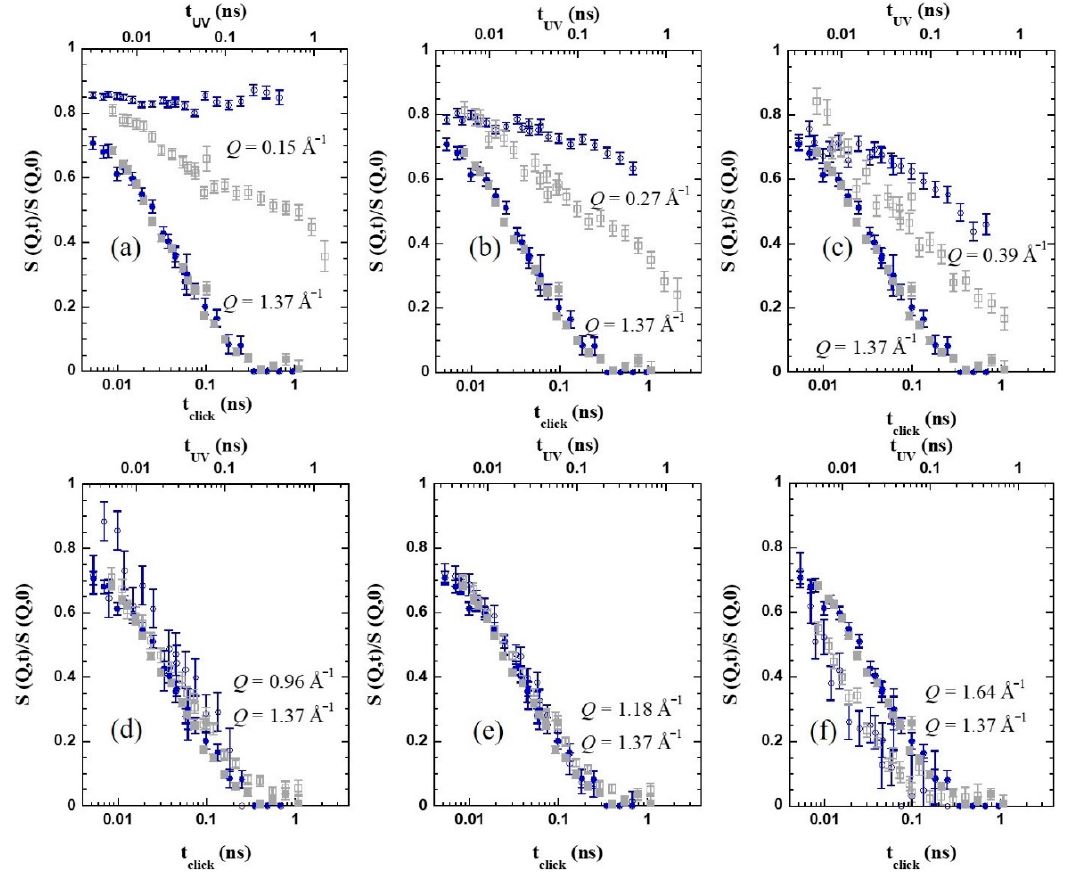
Figure 6. Normalized dynamic structure factor at Q ≈ Q max (filled symbols) and a different Q values (empty symbols), ( a ) Q = 0.15 Å -1 , ( b ) Q = 0.27 Å -1 , ( c ) Q = 0.39 Å -1 , ( d ) Q = 0.96 Å -1 , ( e ) Q = 1.18 Å -1 , and ( f ) Q = 1.64 Å -1 at 360 K for SCNPs samples synthesized via “click” chemistry ( c -SCNPs, circles) and via intra-molecular azide photodecomposition (UV-SCNPs, squares). They are plotted vs the corresponding Fourier time scale (lower x-axis for the c -SCNPs, upper x-axis for the UV-SCNPs).